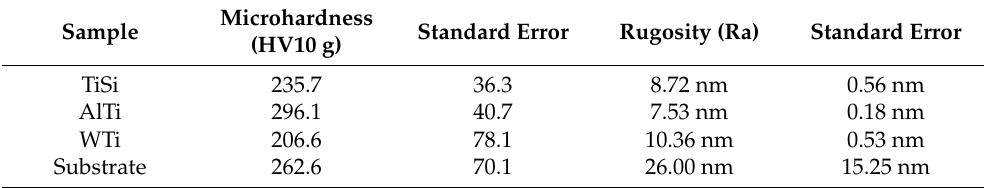
Table 2. Results of microhardness and roughness of TiSi, AlTi, and WTi coatings. Sample